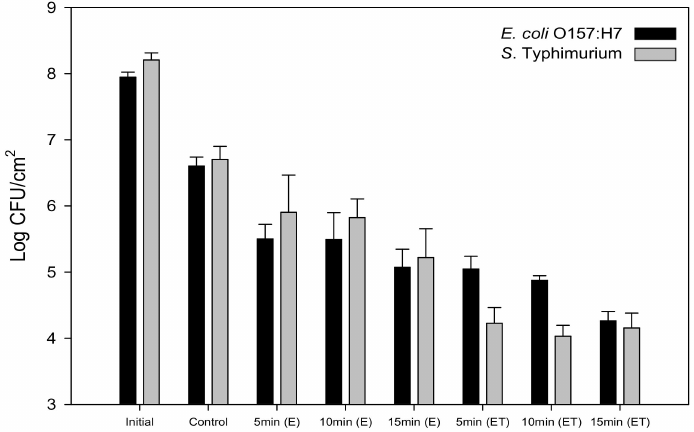
Figure 5. Populations (log CFU / cm 2 ) of E. coli O157:H7 and S . Typhimurium attached to bare stainless steel; stainless steel electrochemically etched 10 V for 5, 10, and 15 min (E); and stainless